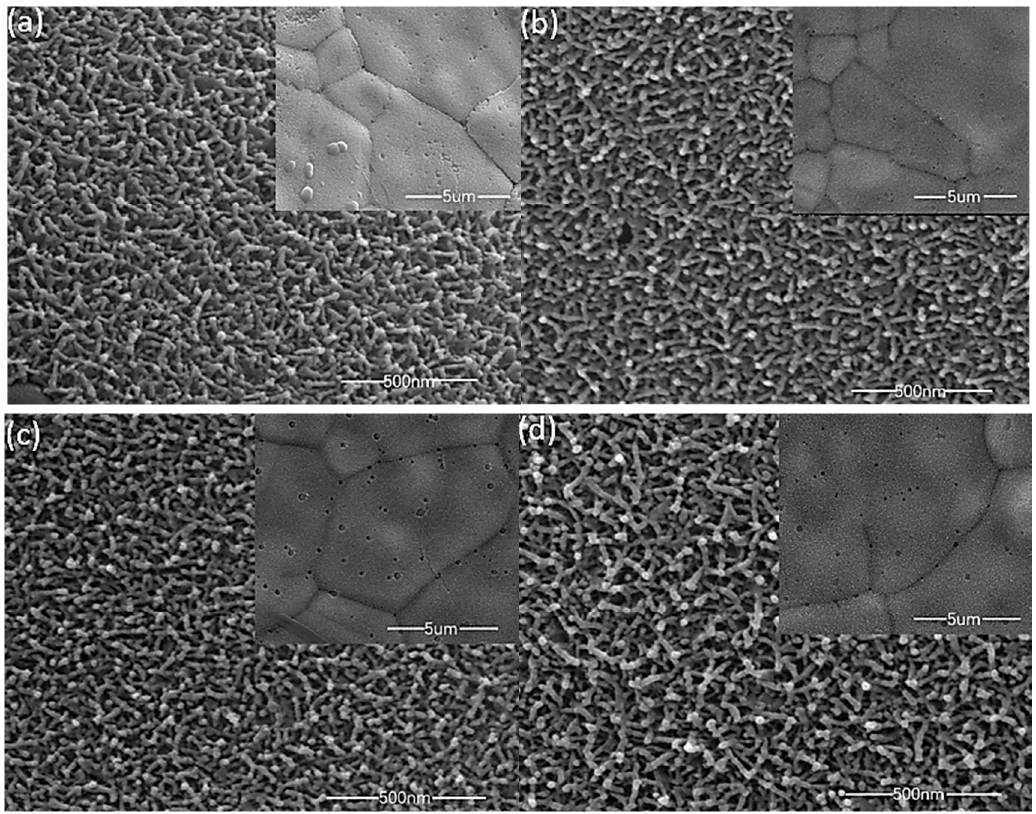
Figure 2. SEM images of different precursor concentrations; (( a ), 0.06 M); (( b ), 0.07M); (( c ), 0.08M); (( d ), 0.09 M).